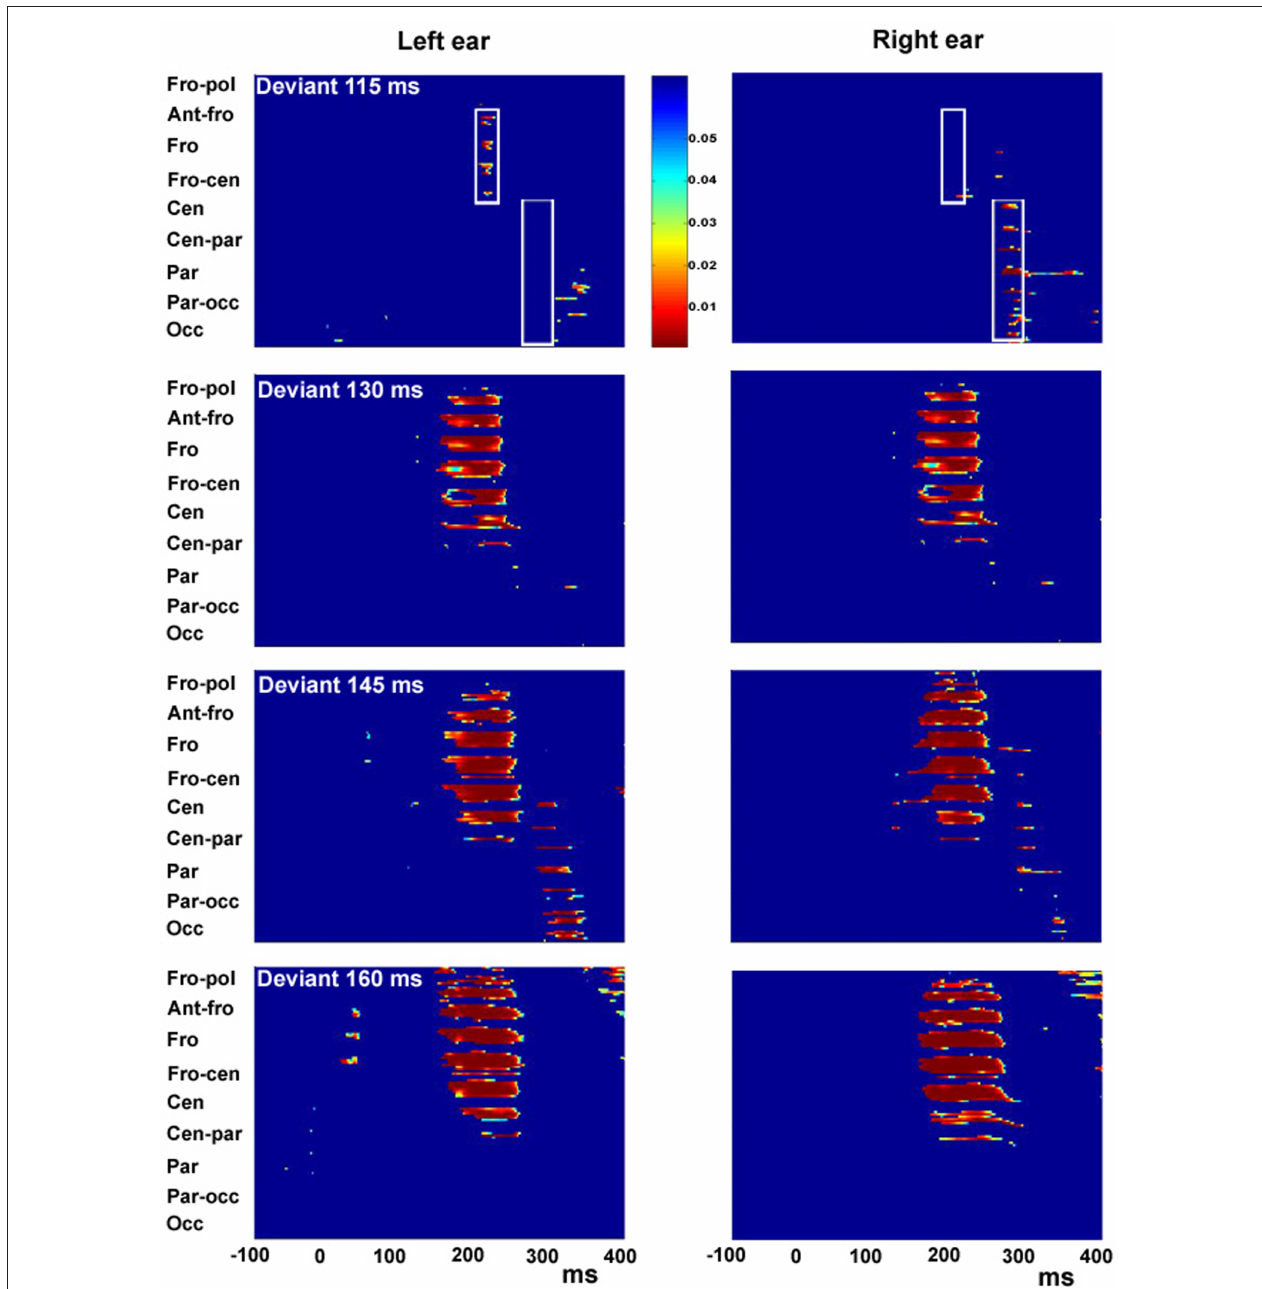
FIGURE 4 | Statistical cluster plots for degree of duration deviants of 115, 130, 145 and 160 ms presented to the left ear (left panel) and right ear (right panel). Color values indicate the result of pointwise t -tests evaluating differences between standard-tone and deviant-tone ERPs across time (x-axis)